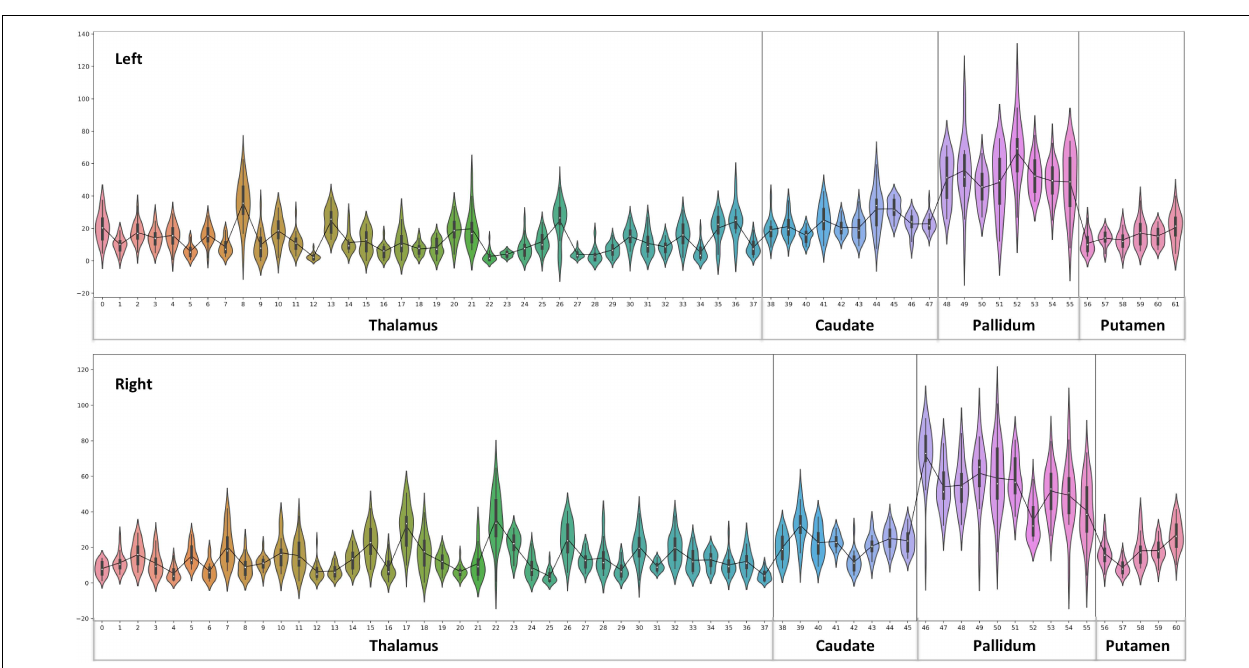
FIGURE 9 | Depiction of values ( > 10 ppb) of diamagnetic sources in Th. (A) The spatial location of diamagnetic parcels with mean values > 10 ppb within the Th. BG does not reveal areas exceeding a threshold of > 10 ppb. The yellow color outline encircles thalamic parcels. (B) Colored version of the first row illustrates regions with higher values. (C) Calculated overlap map of diamagnetic parcels with the thalamic nuclei according to the atlas of Morel show higher values in the anterior Th (AD, AM, and AV), intralaminar nuclei (CeM and CL), the motor and sensory nuclei (VA, VL, VM, VPI, and MV), and in Pv as well as the MD nuclei.